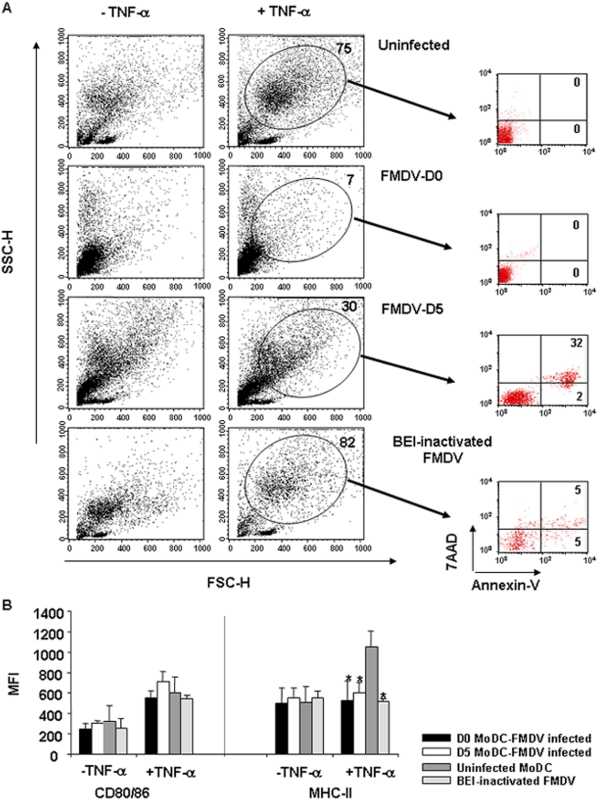
FMDV interferes with MoDC development in vitro.A. Dot plots show forward scatter (FSC) and side scatter (SSC) for uninfected, FMDV-infected at D0 and FMDV-infected at D5 before TNF-α stimulation (−TNF-α) and upon TNF-α treatment (+TNF-α). Note the lack of size increased in FMDV-infected MoDC after TNF-α at either D0 or D5 compared with uninfected control cells. It is shown the population with MoDCs phenotype in a circle and the percentage of this population is indicated. In the right panel, the viability and apoptosis of MoDCs analyzed by annexin-V and 7AAD staining is shown. This is the results from a representative experiment (n = 4) B. The mean fluorescence intensity (MFI) of surface molecules expressed on MoDCs. Each bar represents the MFI of a given surface molecule (CD80/86 or MHC class II) before and after TNF-α addition. Black bars: FMDV-infected MoDC at D0; white bars: FMDV-infected MoDC at D5; gray bars: uninfected cells. Data are average of four independent experiments±SD. Asterisks denote a statistically significant reduction in FMDV-infected MoDC compared with uninfected controls (student t test, p<0.05).